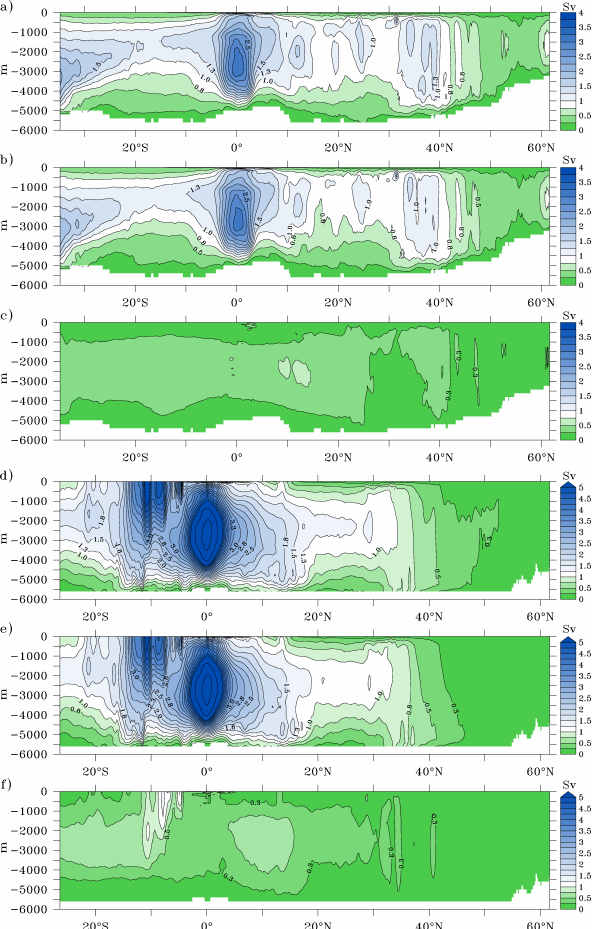
Fig. 13. Chaotic Atlantic (a) , (b) , (c) and Indo-Pacific (d) , (e) , (f) MOC variability for the non-eddying experiments (A100, B100). (a) Unfiltered chaotic MOC variability (based on 5-day averages). (b) Subannual chaotic MOC variability. (c) Chaotic MOC variabil- ity on interannual timescales. (d) , (e) , (f) as (a) , (b) , (c) but for Indo- Pacific. Units areSv and the contour interval is